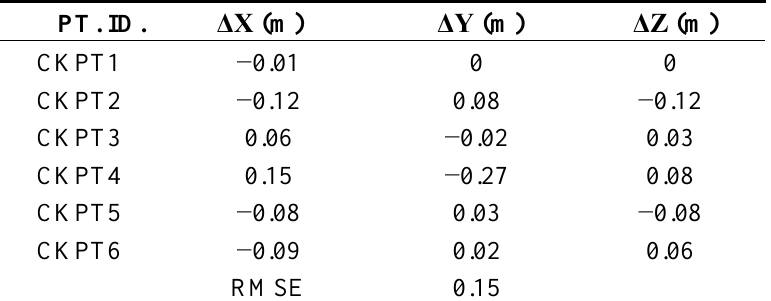
Table 4. Check point